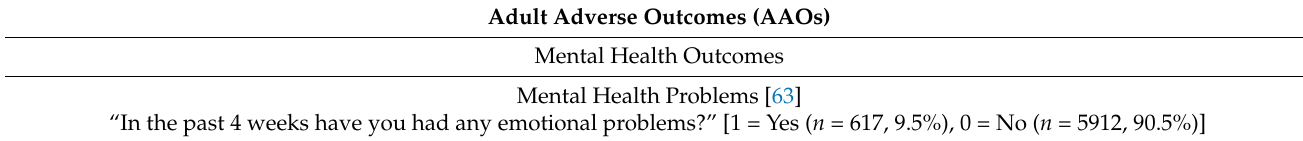
Table 1. Measures and final variable coding for dependent and sociodemographic control variables (National Sexual Health Survey, 1996) †